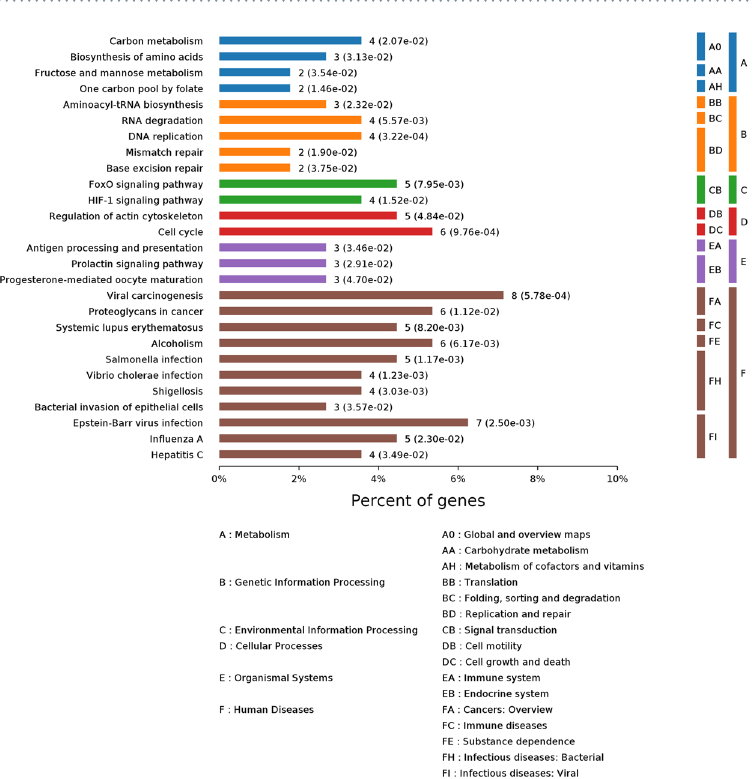
Figure 5. Significantly enriched KEGG pathways of differentially expressed proteins, * p <